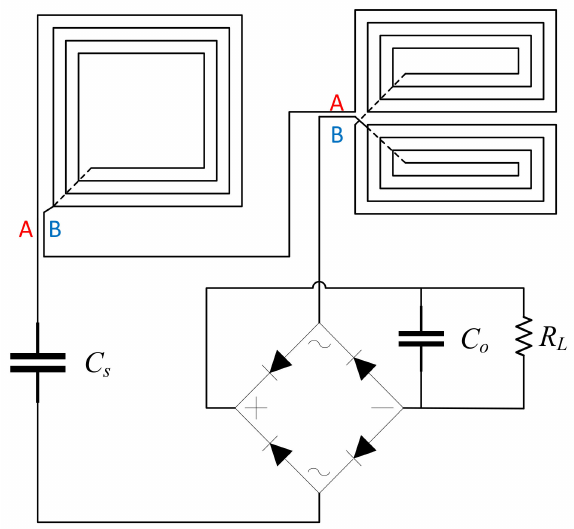
Figure 5. The diagram of R X circuit with connection